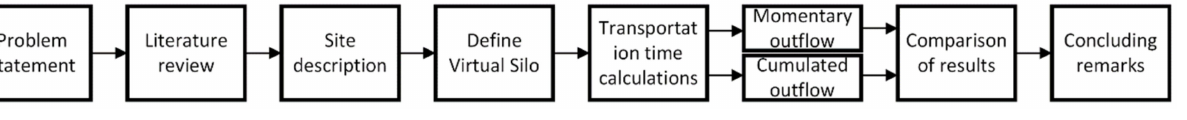
Figure 2. Process map of the